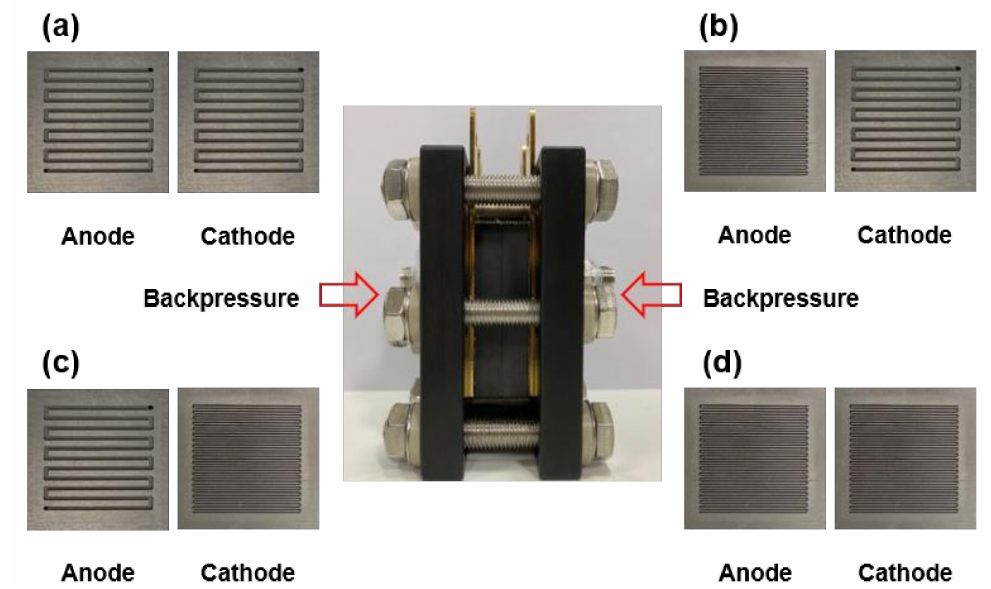
Figure 1. Schematic of the experiment: ( a ) Anodic channel width is 1.0 mm and cathodic channel width is 1.0 mm (A1C1), ( b ) anodic channel width is 0.3 mm and cathodic channel width is 1.0 mm (A3C1), ( c ) anodic channel width is 1.0 mm and cathodic channel width is 0.3 mm (A1C3), and ( d ) anodic channel width is 0.3 mm and cathodic channel width is 0.3 mm